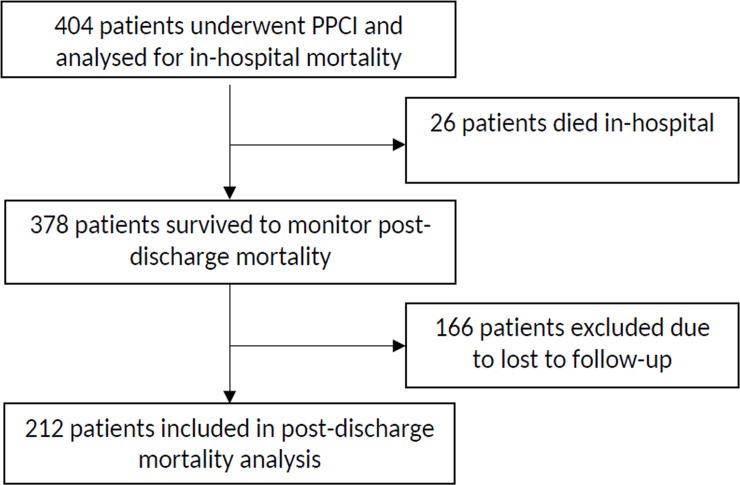
Flowchart of number of patients analyzed.